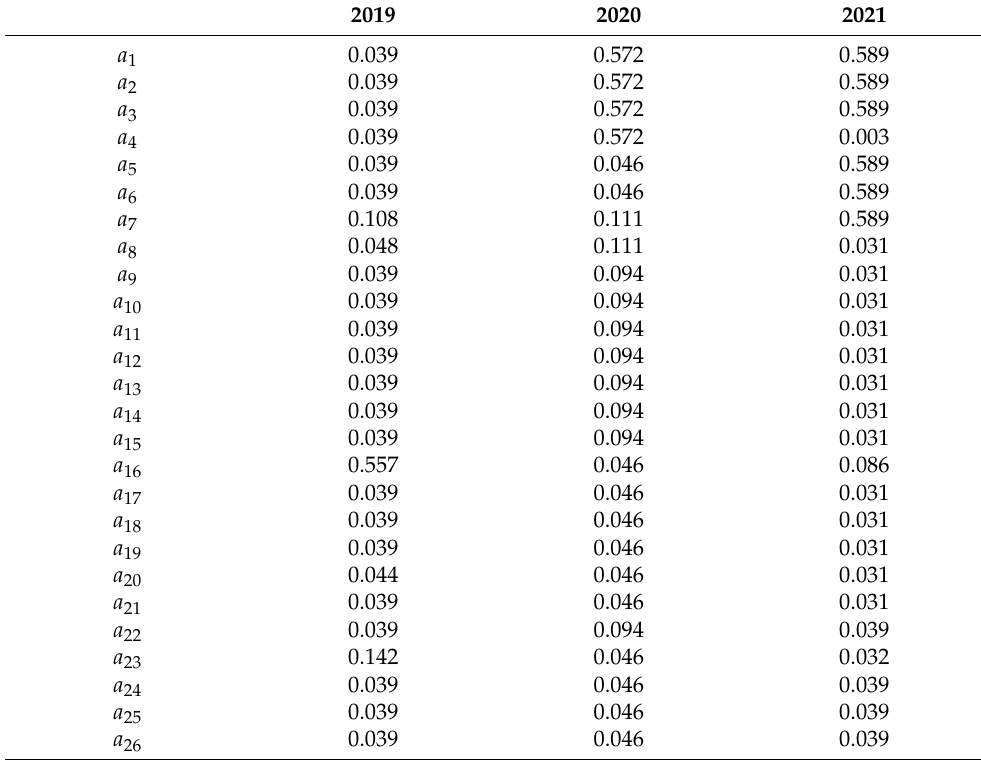
Table 3. Global priority w for 2019, 2020,